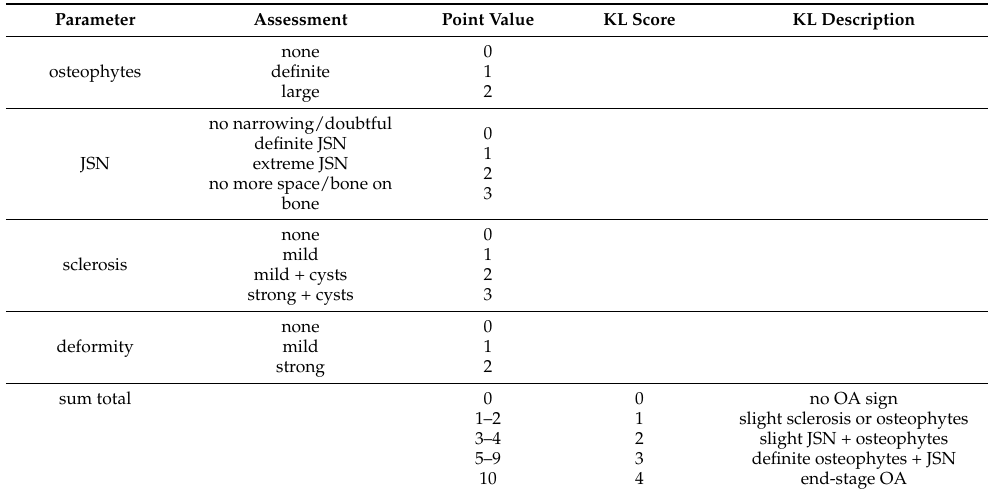
Table 3. KL semi-quantitative assessment: point scores and descriptions (JSN = joint-space narrowing; KL = Kellgren–Lawrence; OA =